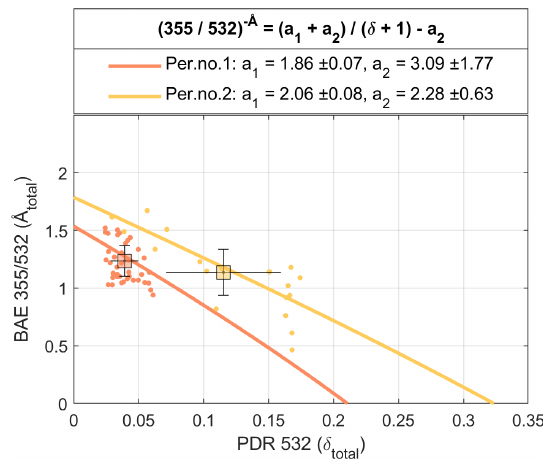
Figure 7. Similar to Fig. 2 but for two periods at Hohenpeißenberg